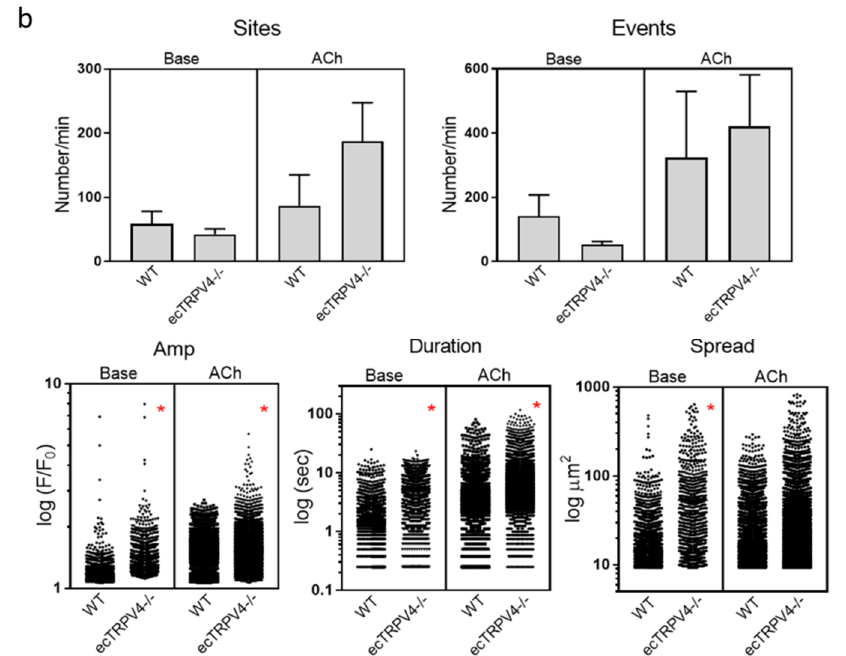
Figure 2. Endothelial Ca 2 + dynamics in ecTRPV4 − / − and WT mouse carotid arteries. ( a ) Opened carotid arteries isolated from wild-type control mice (WT, left) and endothelium-specific TRPV4 knockout (ecTRPV4 − / − , right) mice were loaded with fluorescent Ca 2 + indicator Fluo-4 AM and assessed via spinning disk confocal before and after addition of ACh (10 − 8 M). Maximum projection images of time-lapse recordings (top) and corresponding continuous recordings (bottom) are shown (20 × magnification). Inserts show the time course of events after ACh exposure (for all experiments, n = 8). ( b ) Bar graphs show the number of Ca 2 + signaling sites and events occurring per minute in WT and ecTRPV4 − / − artery endothelia before and after ACh exposure. Individual event parameters (amplitude, duration and spatial spread) are displayed in the corresponding scatterplots. n = 8; * indicates p < 0.05 for ecTRPV4 − / − compared to respective WT.